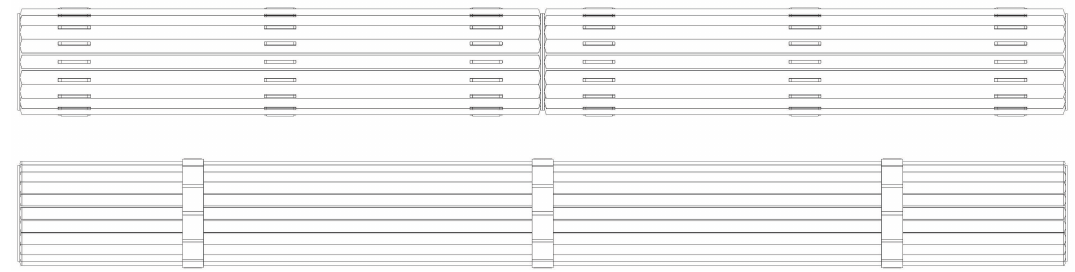
Figure 8: CANDU-CARA and CANDU-37 fuel elements comparison.